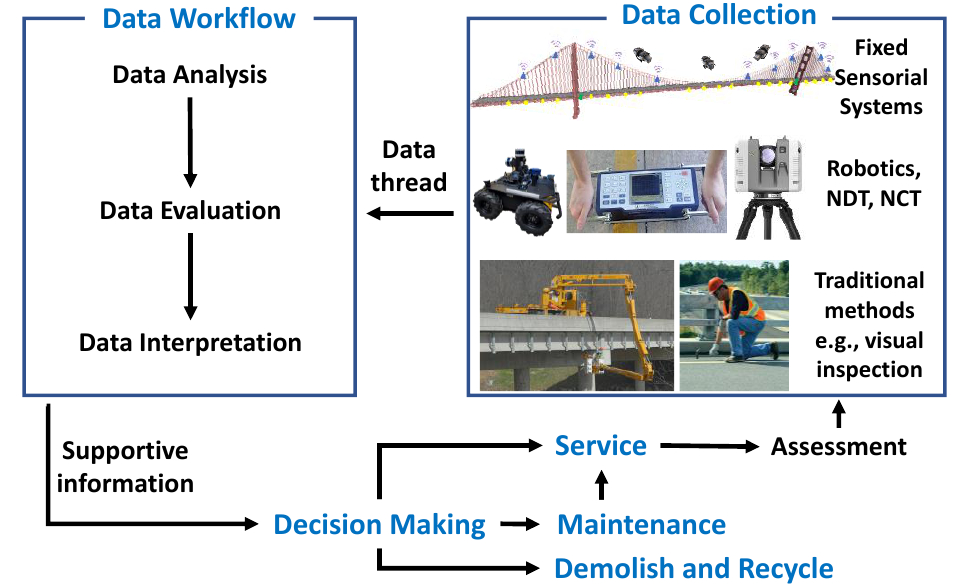
Figure 3. Typical idealized condition assessment procedure for civil structures.